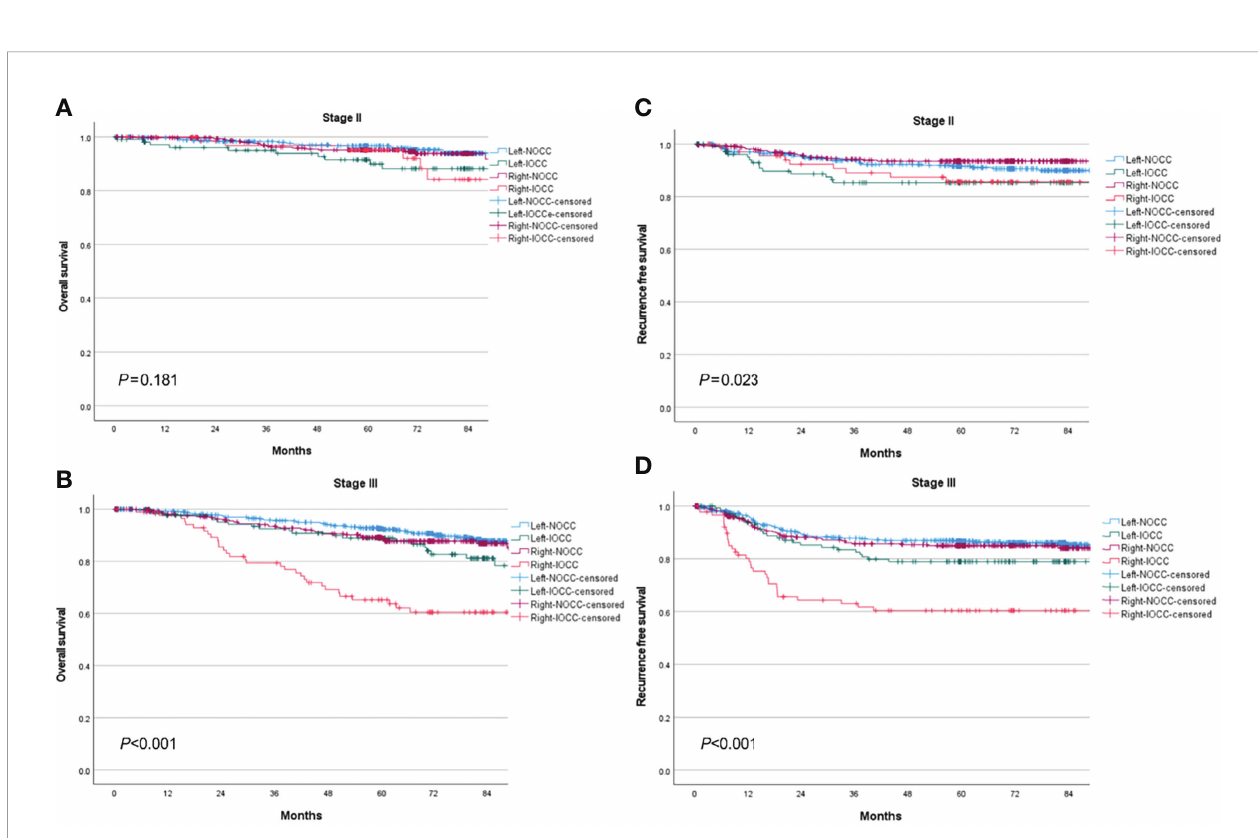
FIGURE 3 | Overall survival and recurrence-free survival between stage II and stage III IOCC and NOCC by tumor location. (A) Overall survival of stage II colon cancer by obstruction status and tumor location. (B) Overall survival of stage III colon cancer by obstruction status and tumor location. (C) Recurrence-free survival of stage II colon cancer by obstruction status and tumor location. (D) Recurrence-free survival of stage III colon cancer by obstruction status and tumor